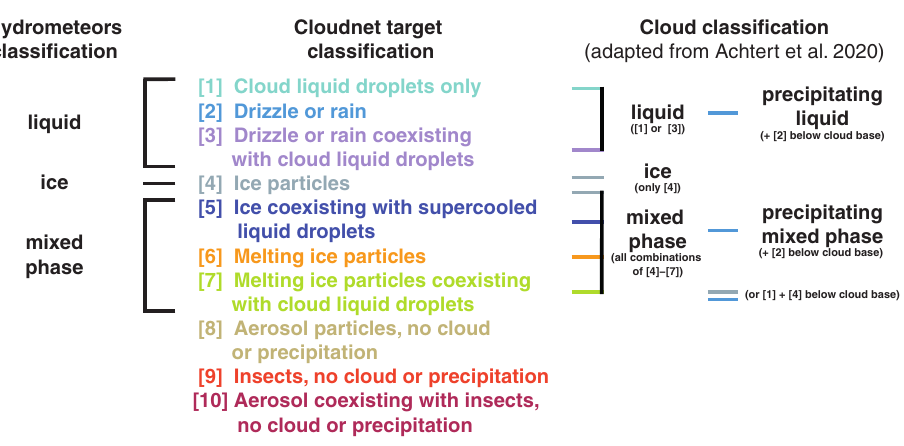
Figure 5. Data availability for the Bucharest–M˘agurele station between December 2019 and May 2021. White bars represent the maximum possible number of vertical profiles for each month. The grey bars represent the number of profiles with hydrometeors, and the blue bars represent the number of clear-sky profiles (as a percentage of the total number of possible profiles).